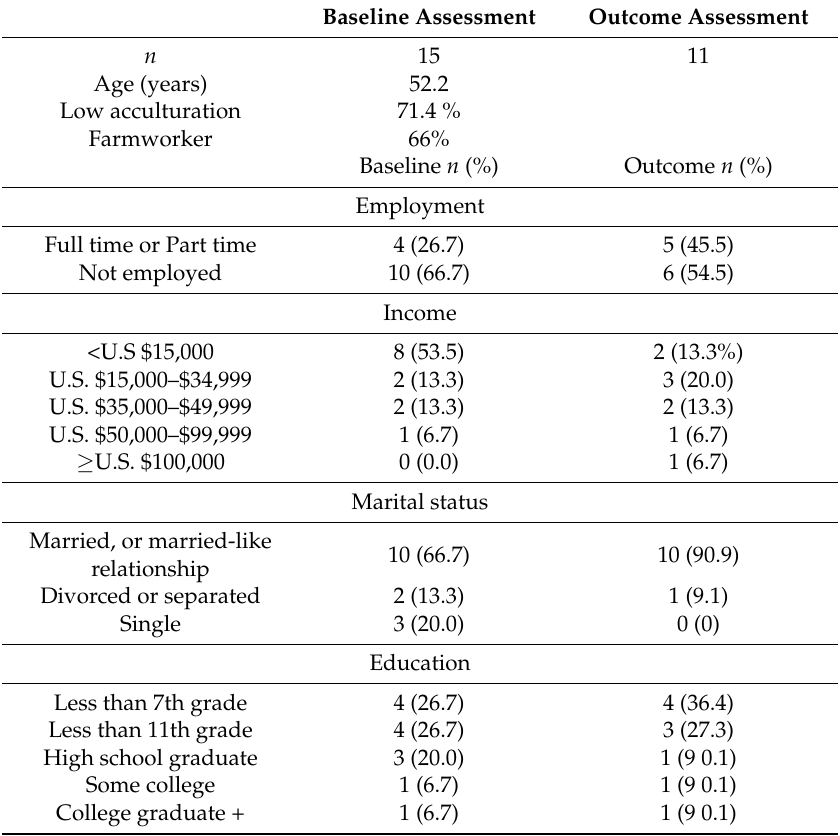
Table 2. Sociodemographic characteristics of participants at baseline and outcome